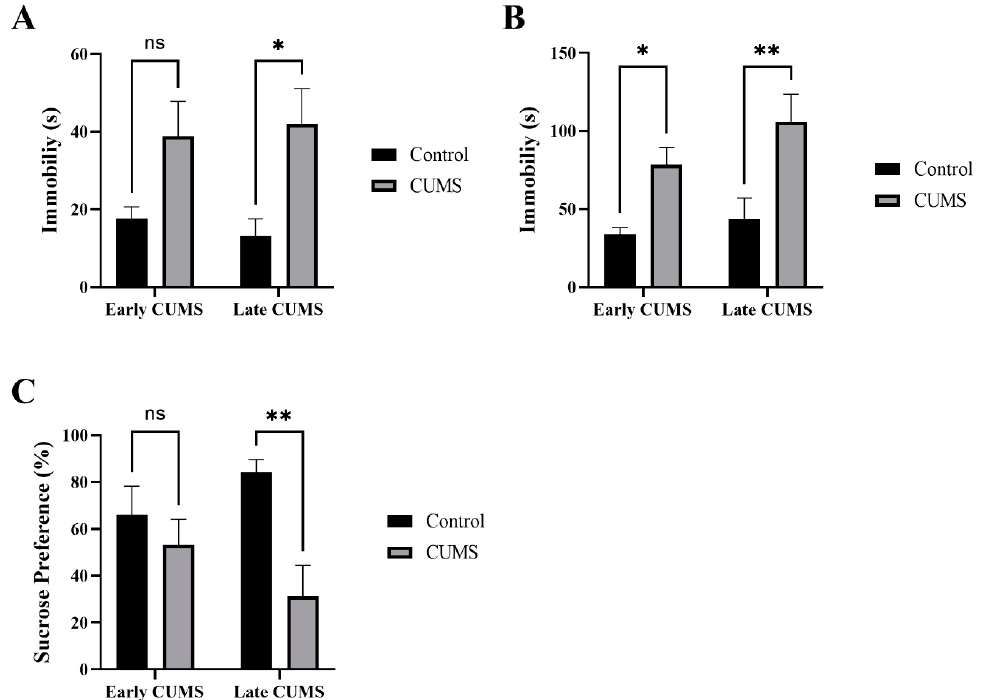
Figure 5. The effect of early and late CUMS on depression tests in the ( A ) TST, ( B ) FST, and ( C ) SPT. Two-way ANOVA was used, followed by Šídák’s multiple-comparisons test. (*) indicates a significant difference between the CUMS groups and the control group at p > 0.05, ** p < 0.01. ns: not significant.